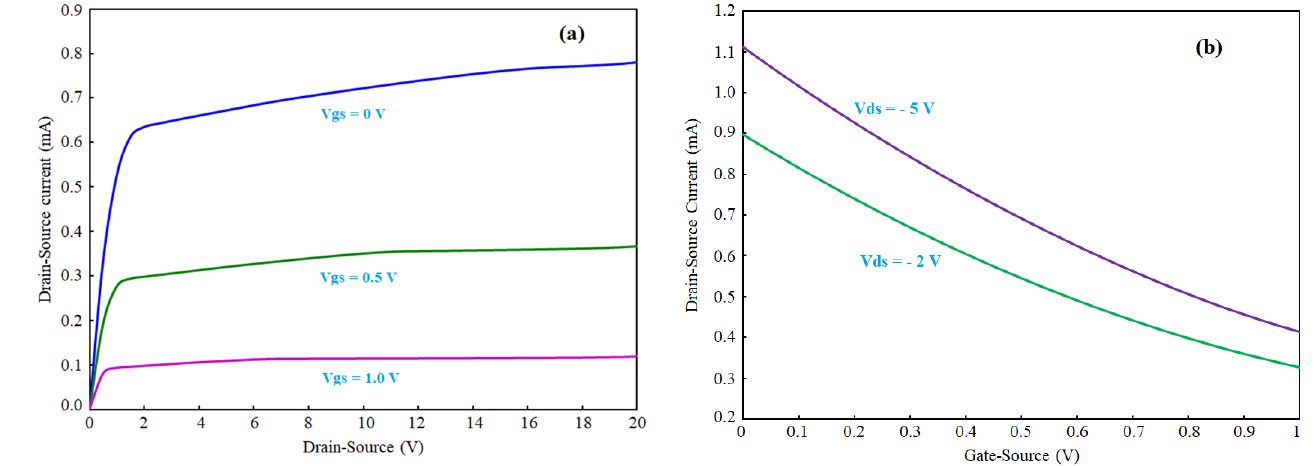
Figure 8. The Ids–Vds and Ids–Vgs curves of OG ‐ JFET. ( a ): Ids vs. drain–source voltage. ( b ): Ids vs. back ‐ gate voltage.